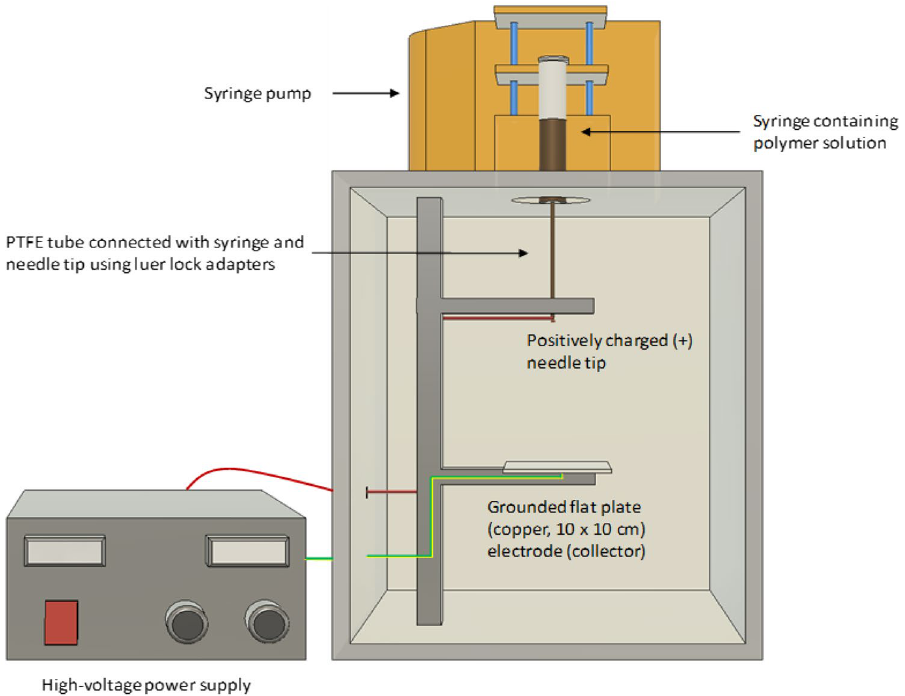
Figure 1. Schematic illustration of electro-spinning setup with a flat plate ground-electrode for collecting randomly oriented lignin fibres. Autodesk (Fusion360), version 2018 . San Rafael, CA, USA. https:// www. autod esk.